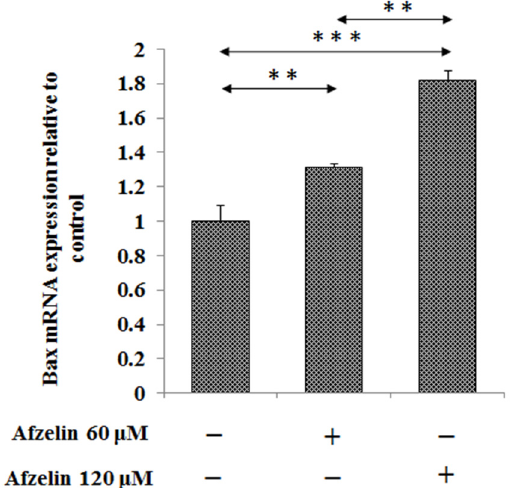
Figure 4. The effect of afzelin on pro-apoptotic Bax mRNA expression in AGS gastric cancer cells. The cells were incubated for 24 h with 60 and 120 µ M afzelin. mRNA was determined by RT-PCR. The results are presented as a relative fold change in mRNA expression of gene in comparison of gene in control where expression was set as 1. ± SD are the mean of triplicate cultures. ** p < 0.01, *** p <